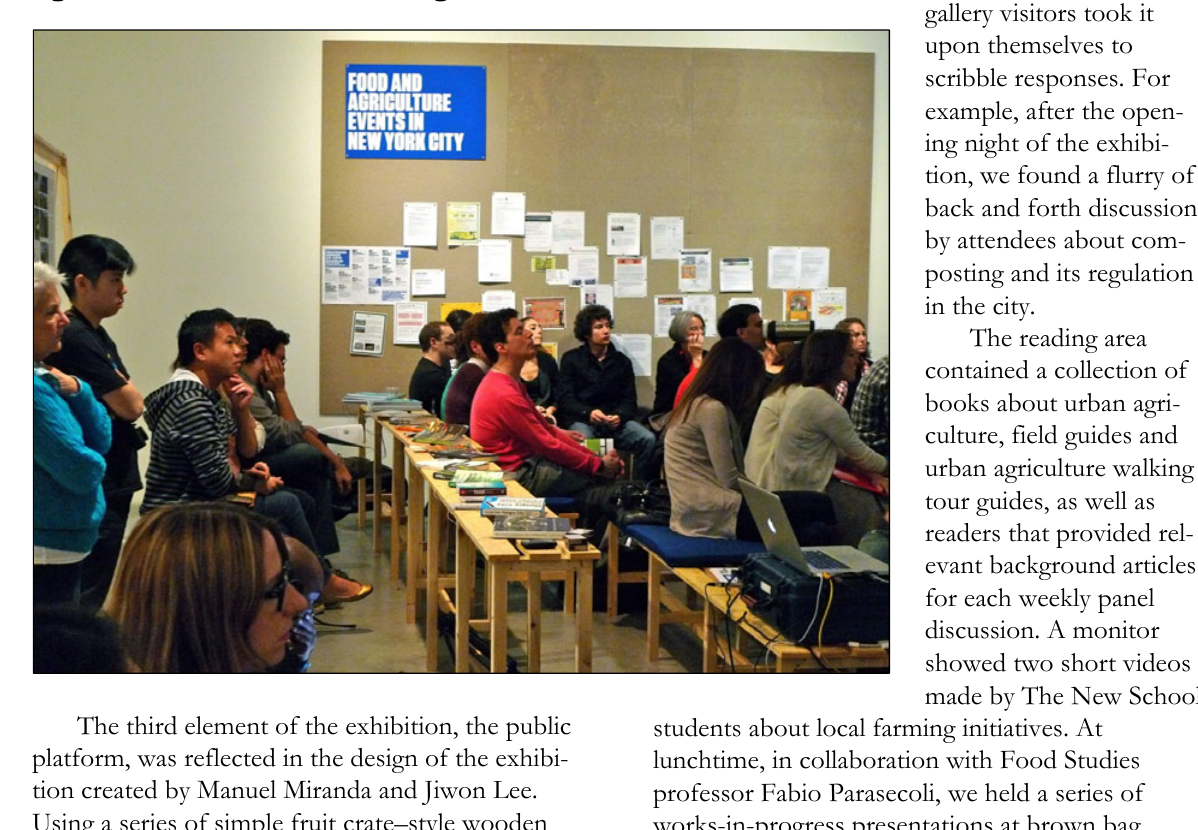
Figure 3. Notice Board of Food and Agriculture